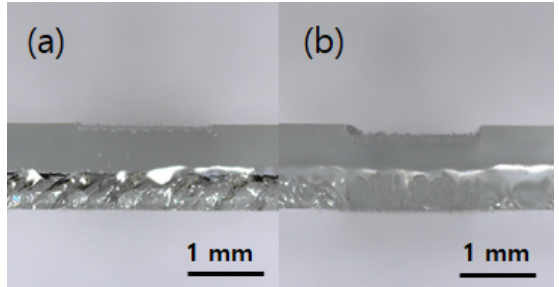
Figure 12. Cross section of the grooves produced by multiple laser scans with a non-zero scan spacing (laser power: 2.28 W, scan speed: 25 mm / s, pulse repetition rate: 30 kHz, and scan spacing: 30 µ m). Scanning scheme: ( a ) method 2 in Figure 2 and ( b ) method 3 in Figure 2 (number of scans per scan track: 5 and number of scan tracks: